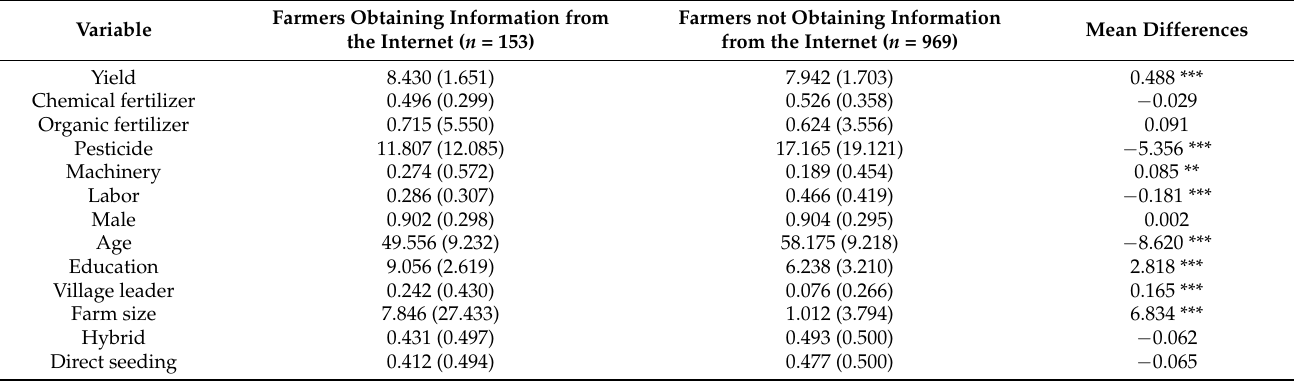
Table 2. Differences between farmers obtaining and not obtaining information from the